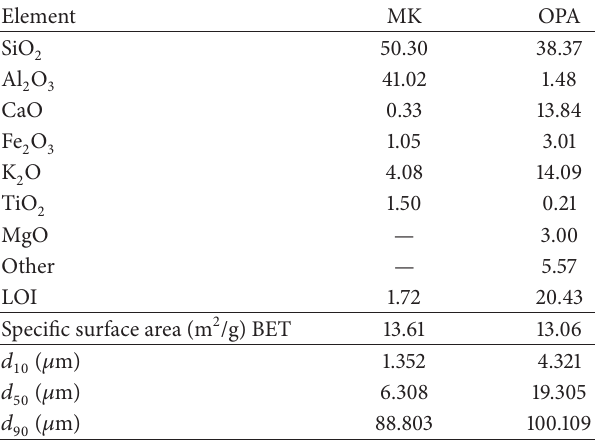
Table 1: Chemical composition (wt.%) and physical property of MK and OPA.